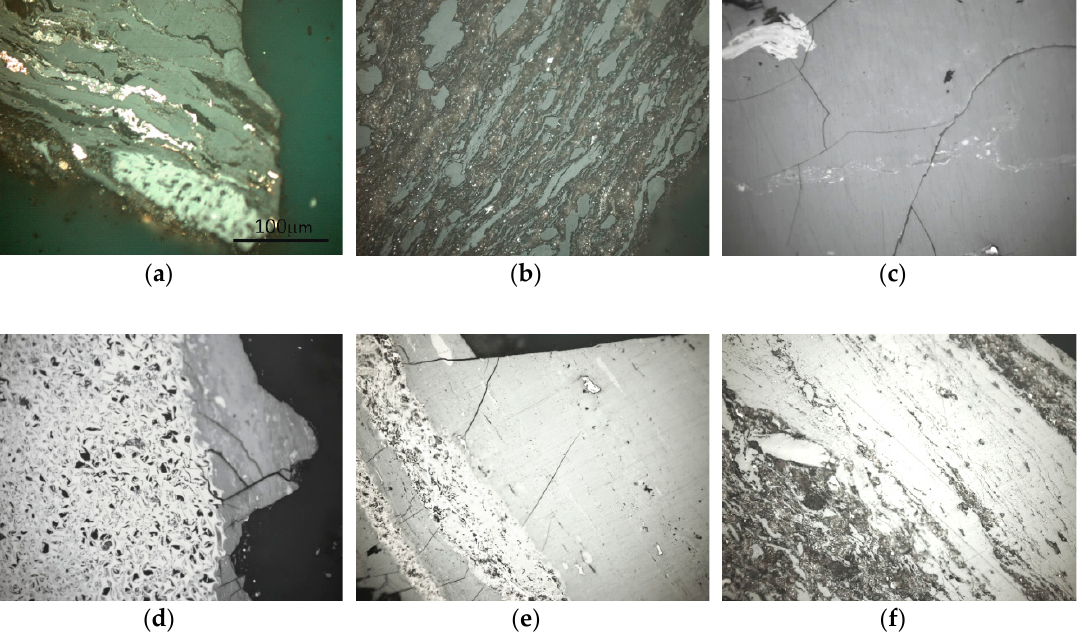
Figure 3. Share of main maceral groups in samples of various metamorphism degree (recalculated to mineral matter-free (mmf)). Figure 4. Mineral matter content in samples of various metamorphism degrees.